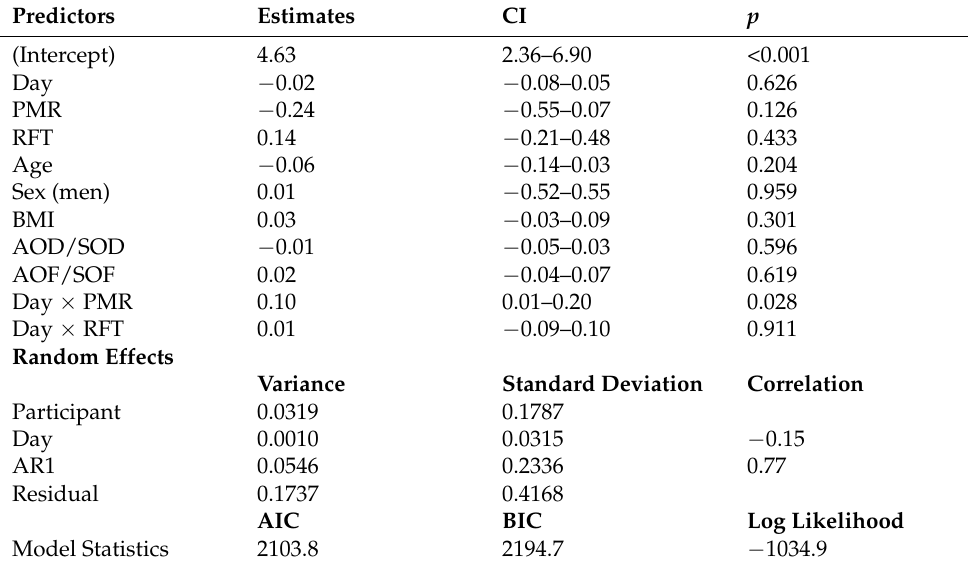
Table 2. Linear Mixed Effect Model, using Resting HRV (ln RMSSD) as the Criterion.